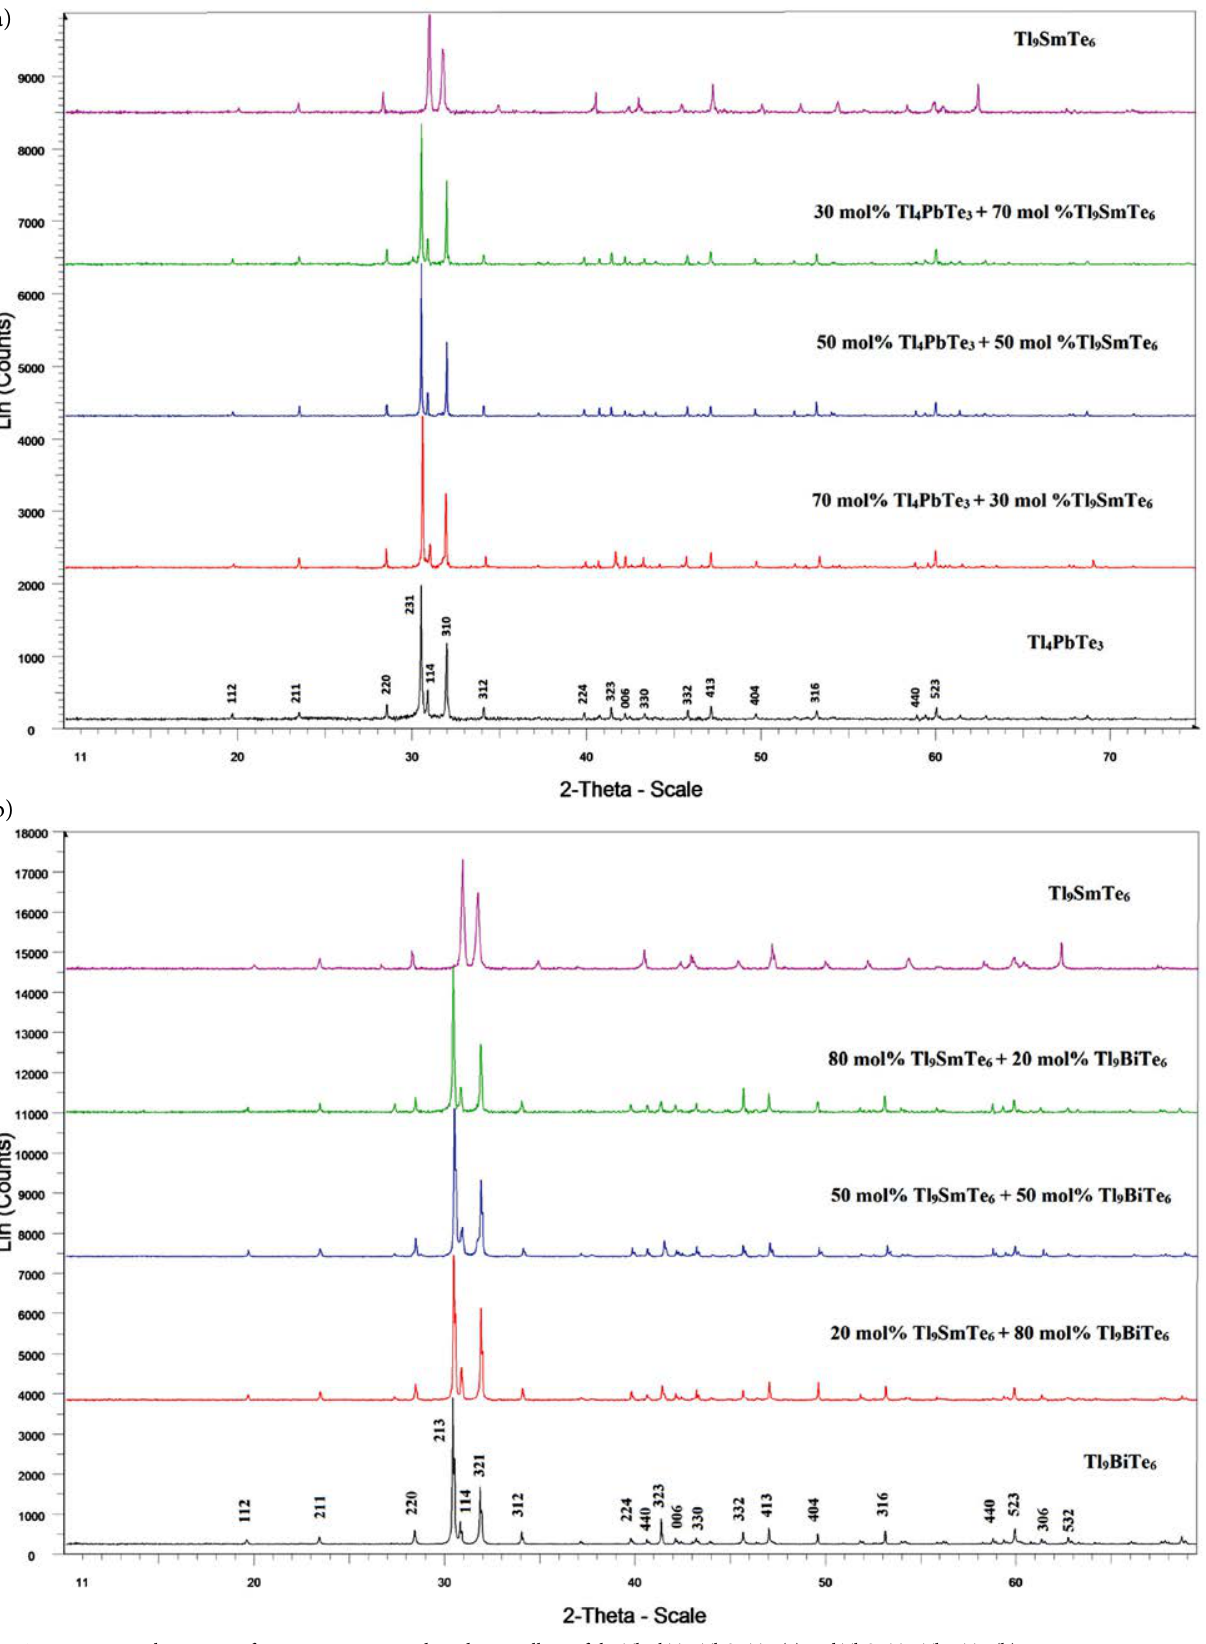
Fig. 2. XRD powder patterns for starting compounds and some alloys of the Tl 4 PbTe 3 -Tl 9 SmTe 6 (a) and Tl 9 SmTe 6 -Tl 9 BiTe 6 (b)